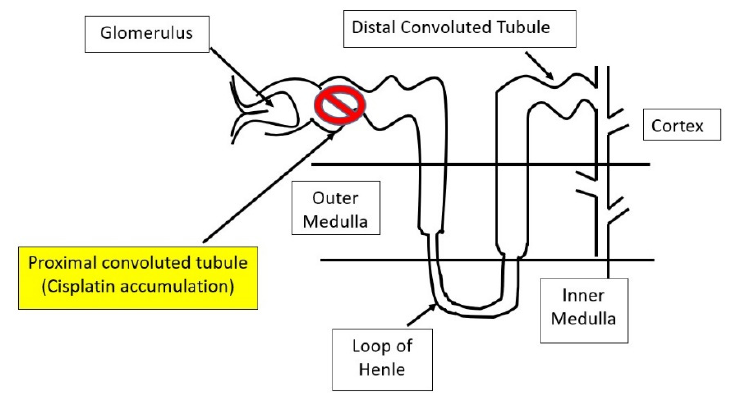
Figure 1. Diagram showing the proximal convoluted tubule (PCT) as the major site of cisplatin accumulation and toxicity in the nephrons.